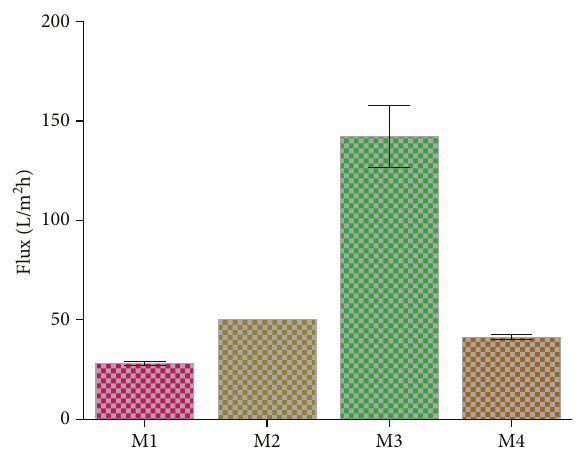
Figure 8: Pure water fl ux calculated for the fabricated membranes. Error bars represent standard deviation, and three measurements were taken for water fl ux.